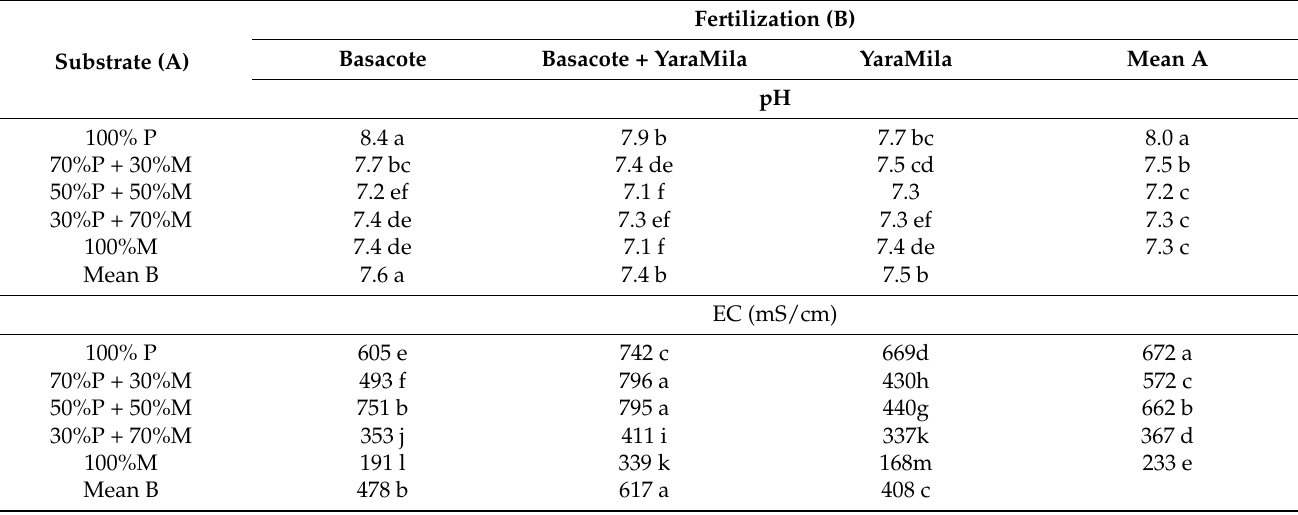
Table 13. pH and EC of substrates in Hydrangea arborescence ‘Annabelle’ grown in containers with five different